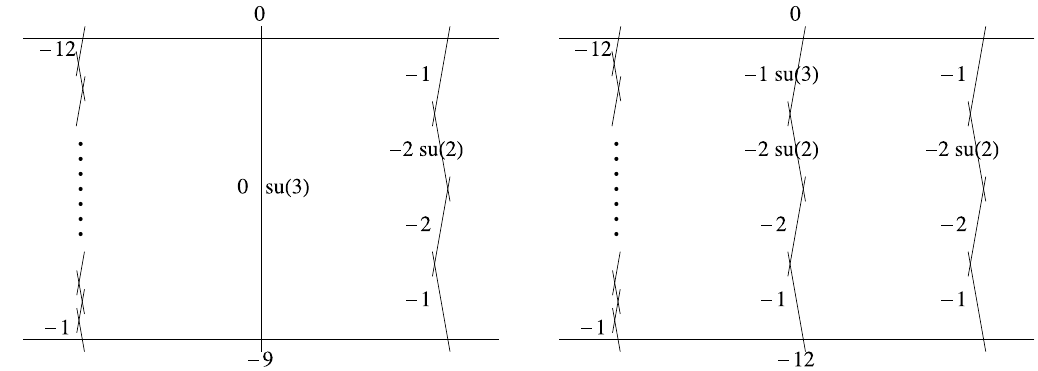
Figure 6. The base of the example with Hodge numbers f 261 ; 45 g . Left: before resolution. Right: after resolving (4,6) points in the base. The top curve is D 102 and the bottom curve is ~ D 97 . The curves in the left chain from top to down are in the order f D 1 ; D 2 ,. . . , D 96 g , in the middle